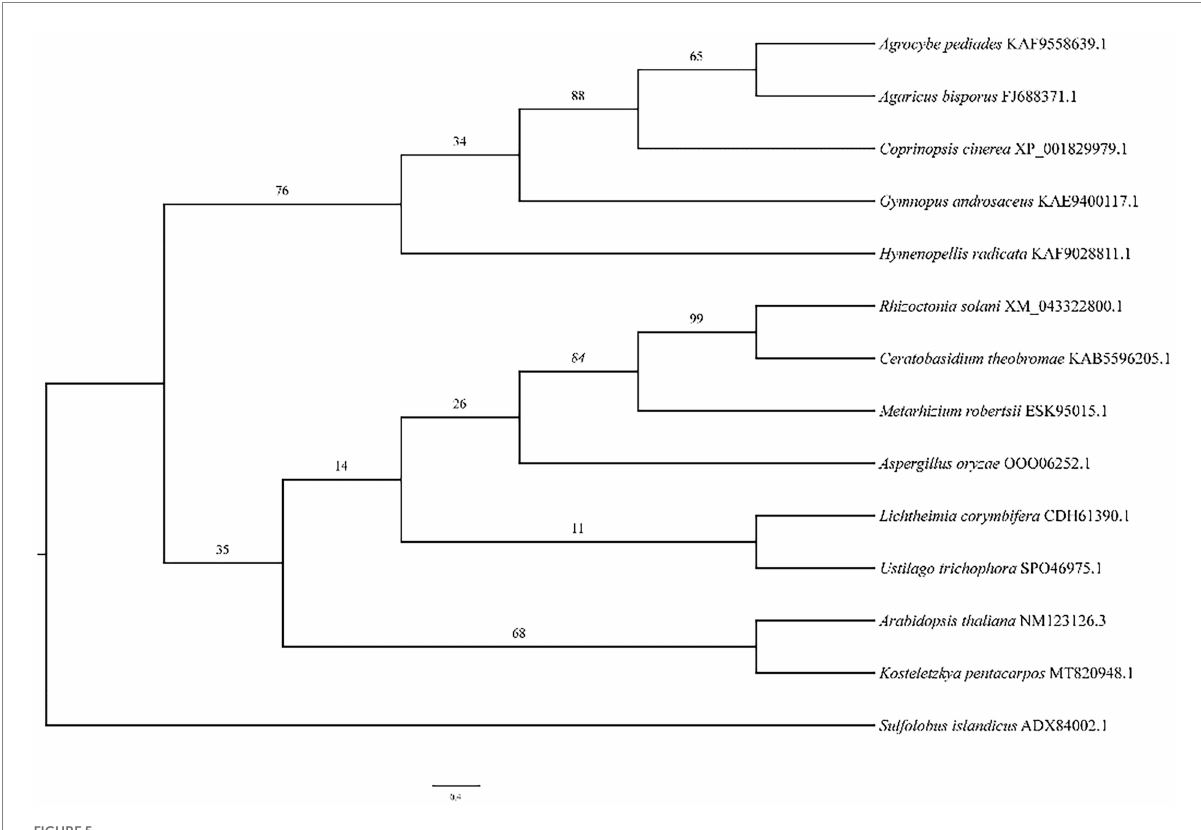
FIGURE 5 The phylogenetic tree analysis of HSP20 in A. bisporus.